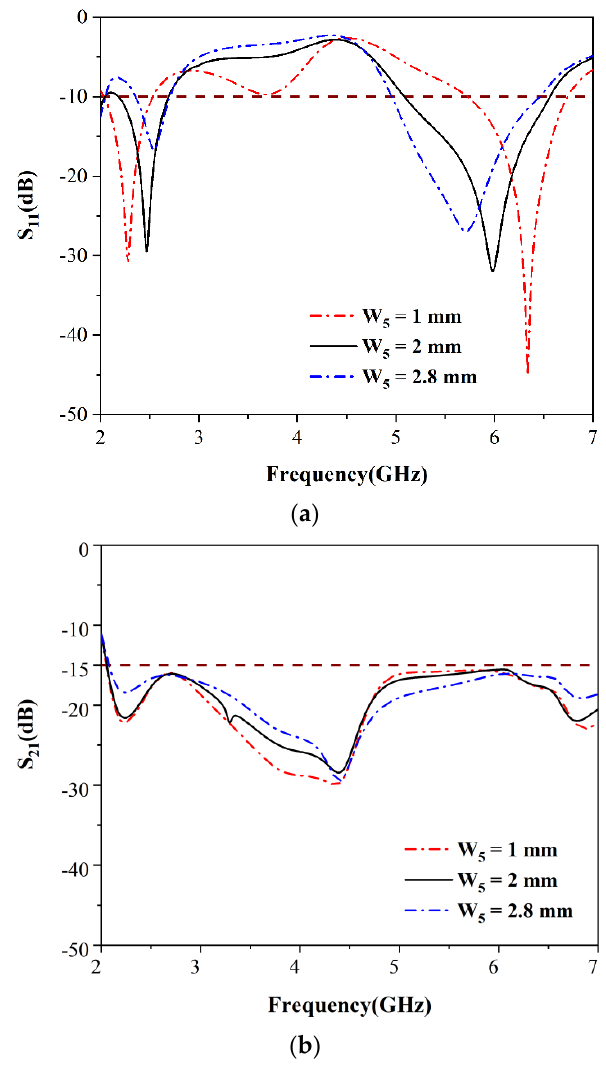
Figure 3. Simulated parameters with different values of W 5 . ( a ) Reflection coefficients; ( b ) isolation.